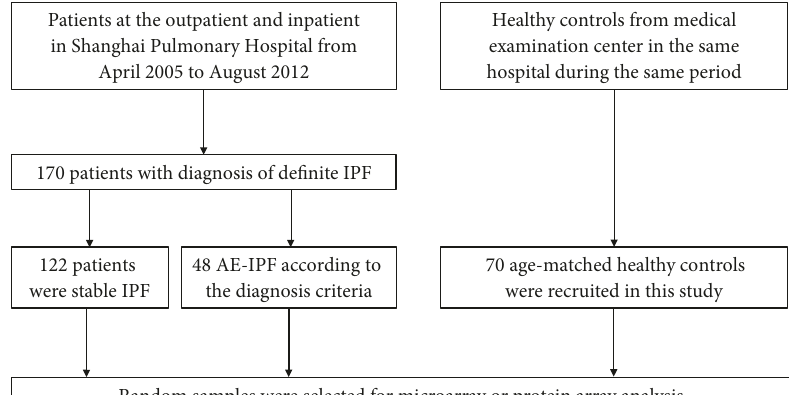
Figure 1: Flow chart of patient